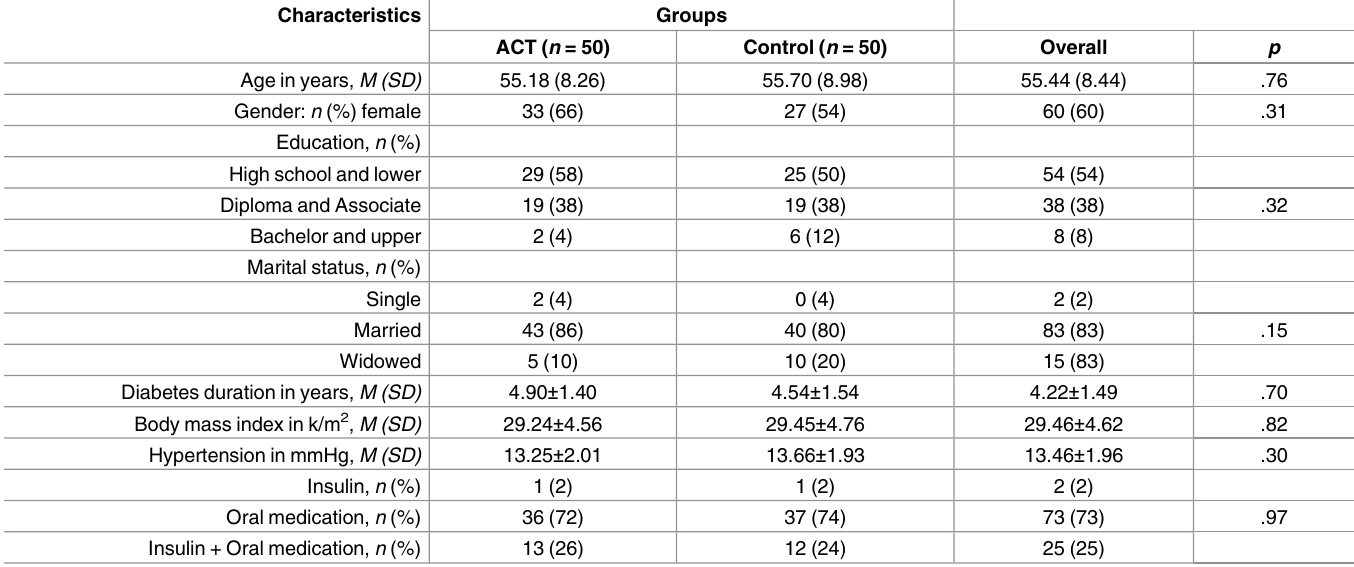
Table 1. Demographic and clinical characteristics of patients with type 2 diabetes (N =